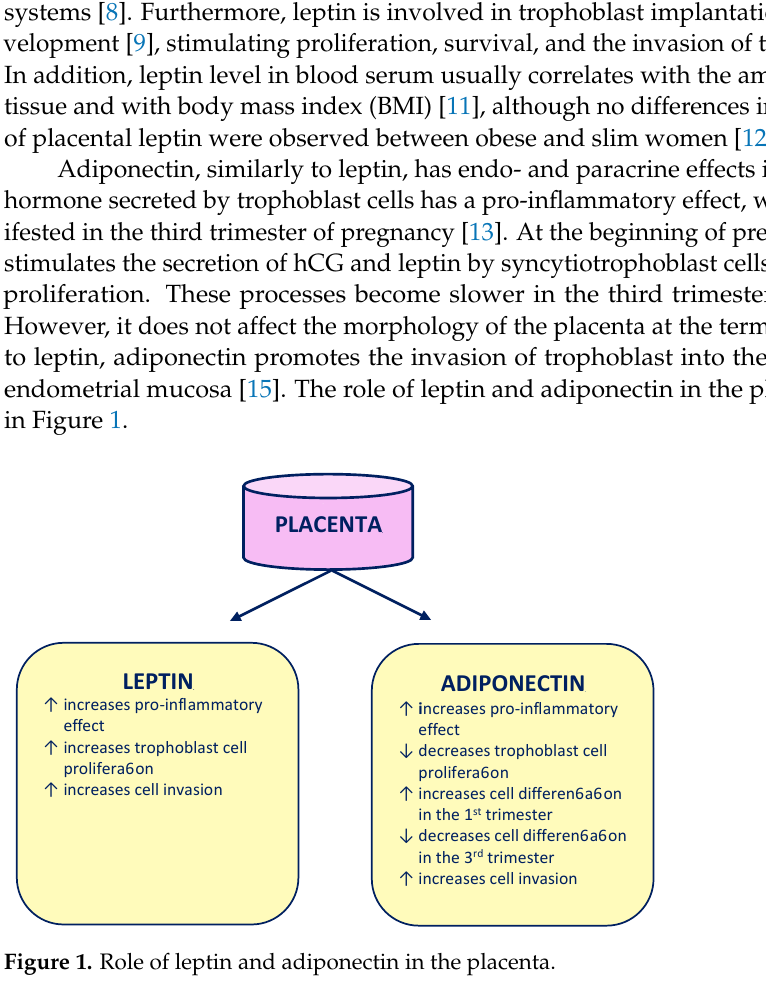
Table 1. Study group clinical characteristics.